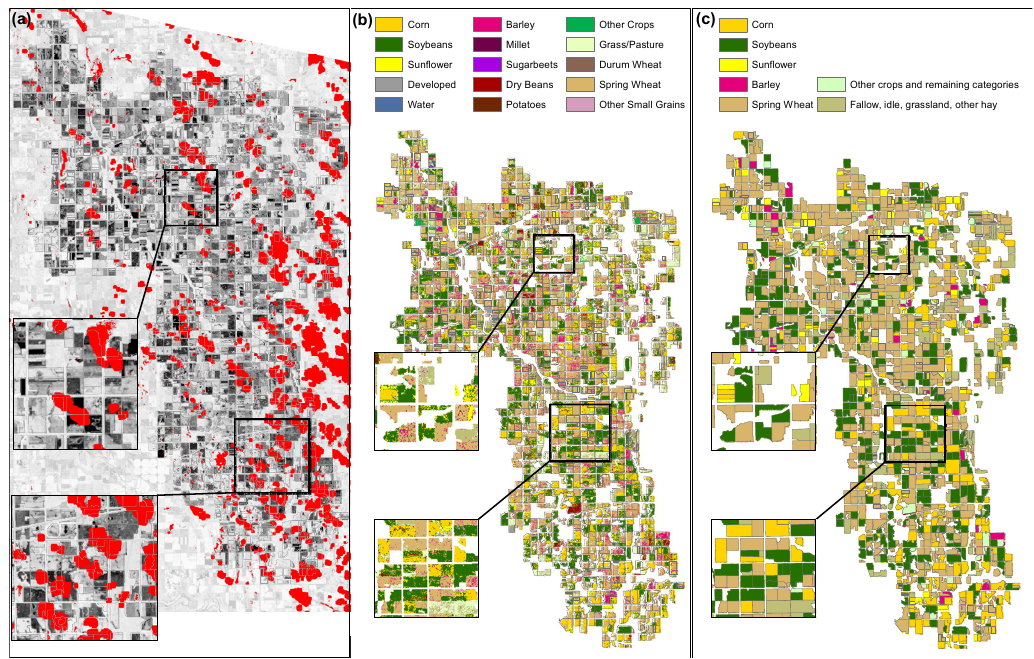
Figure 3. Development of input and reference datasets for individual agricultural fields. Red patches represent clouds used to mask / remove contaminate pixels during the field spatial aggregation of NDVI pixel values ( a ). The raw crop data layer (CDL) dataset ( b ) was processed to determine the majority crop type for each field based on the pixel-field zonal statistics ( c ). This operation was performed for the 2000 (shown) and 2005